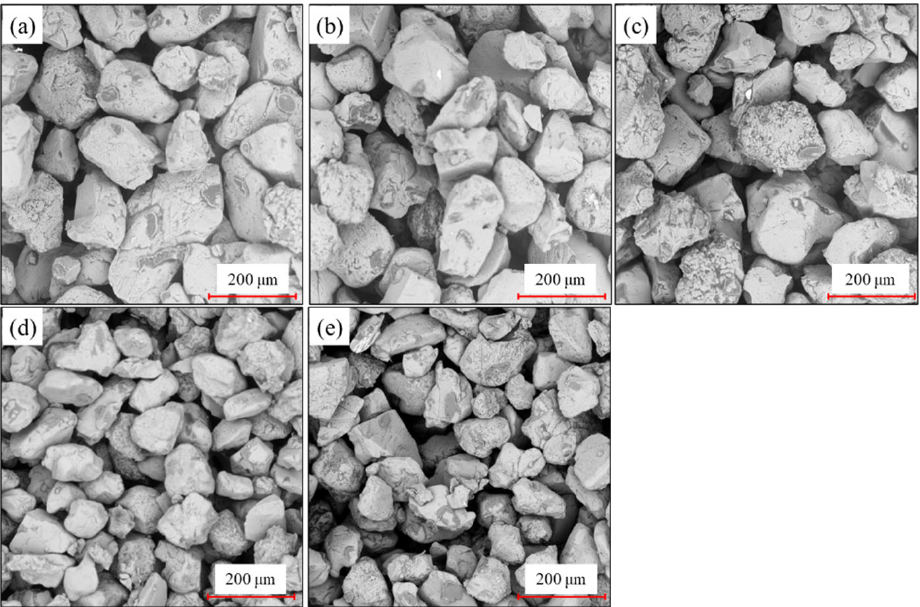
Figure 15. Collage of the SEM images of the 3DP rocks printed with different blends of sand mixtures: ( a ) Type I, ( b ) Type II, ( c ) Type III, ( d ) Type IV, ( e ) Type